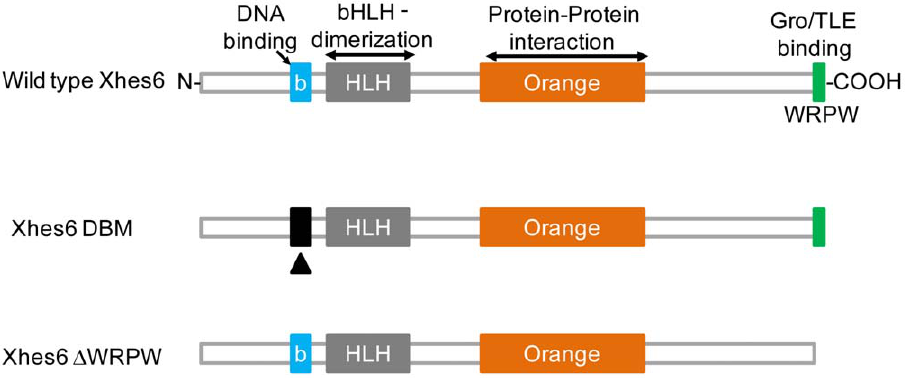
Figure 1. Conserved domains in Xhes6 and mutants used in this study. Xhes6 contains a conserved basic domain, required for DNA binding, a helix-loop-helix domain, implicated in dimerization with Xhes6 and other bHLH proteins, an ‘‘orange’’ domain, comprising the third and fourth helices of the protein, required for protein-protein interaction, and a C terminal WRPW motif, required for binding to Groucho/TLE family transcriptional coregulatory proteins. In this study a mutant of the basic domain which is unable to bind DNA (Xhes6 DBM) and a mutant lacking the WRPW motif (Xhes6 D WRPW) were used.